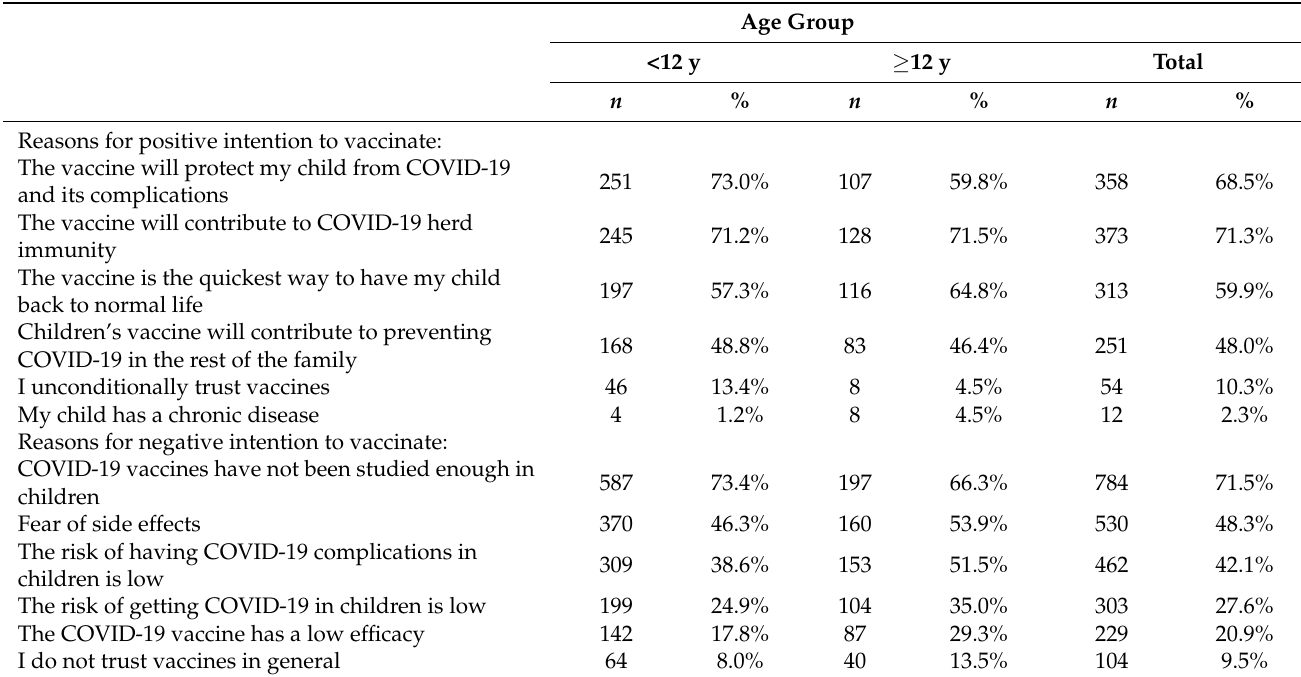
Table 3. Reasons for positive or negative intention to vaccinate by target age group (multiple answers